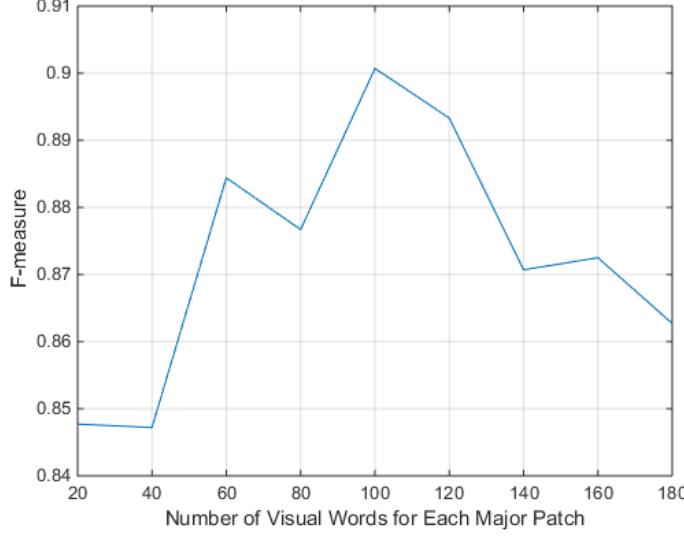
Figure 12. Influence of the number of visual “words” of each major patch for the F-measure of our proposed method.